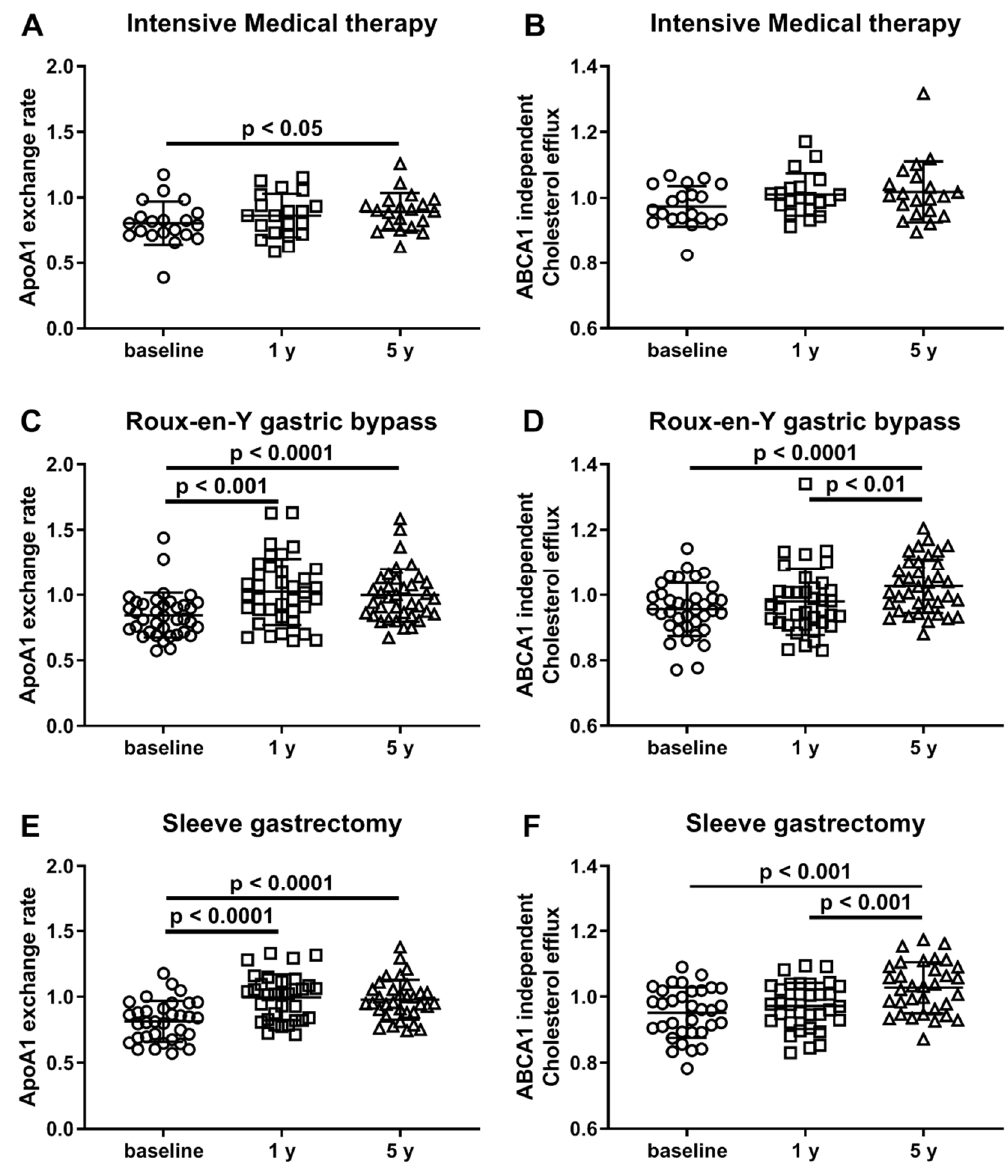
Figure 1. HDL function is improved after bariatric surgery. ApoA1 exchange rate ( A , C , E ) and ABCA1-independent cholesterol efflux capacity ( B , D , F ) were assayed in human serum samples from 90 STAMPEDE subjects at baseline (circles), 1 year (squares), 5 years (triangles) after receiving intensive medical therapy ( A, B , n = 20), Roux-en-Y gastric bypass ( C, D , n = 37) or sleeve gastrectomy ( E, F , n = 33) surgeries.